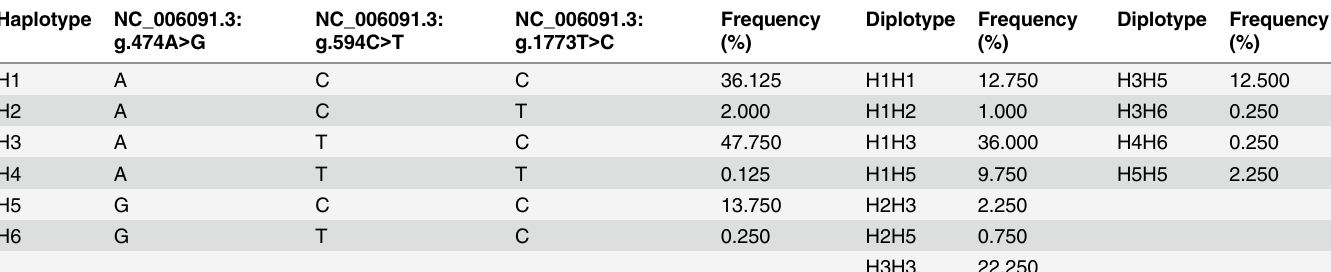
Table 5. Haplotypes and diplotypes inferred based on the 3single nucleotide polymorphisms.